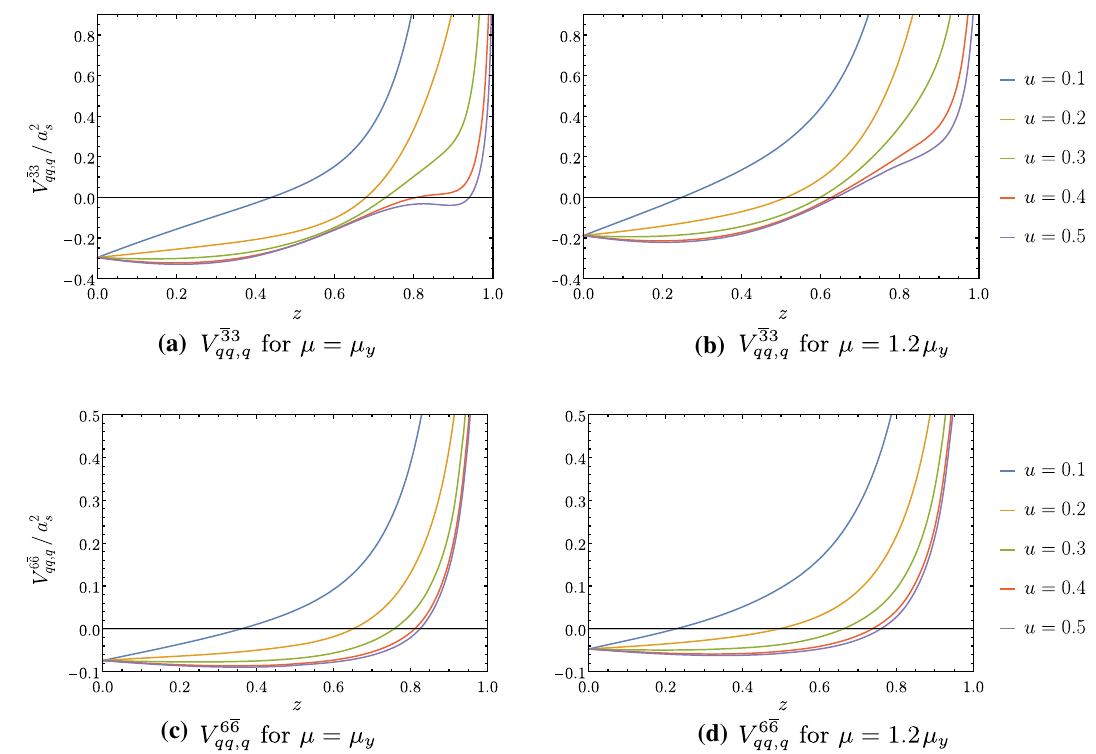
Fig. 7 As Fig. 6 but for the kernels in (53), which give the DPDs for the parton combination uu . Since these kernels are symmetric under the interchange z 1 ↔ z 2 of the two momentum fractions, we can limit ourselves to the region u ≤ 0 . 5